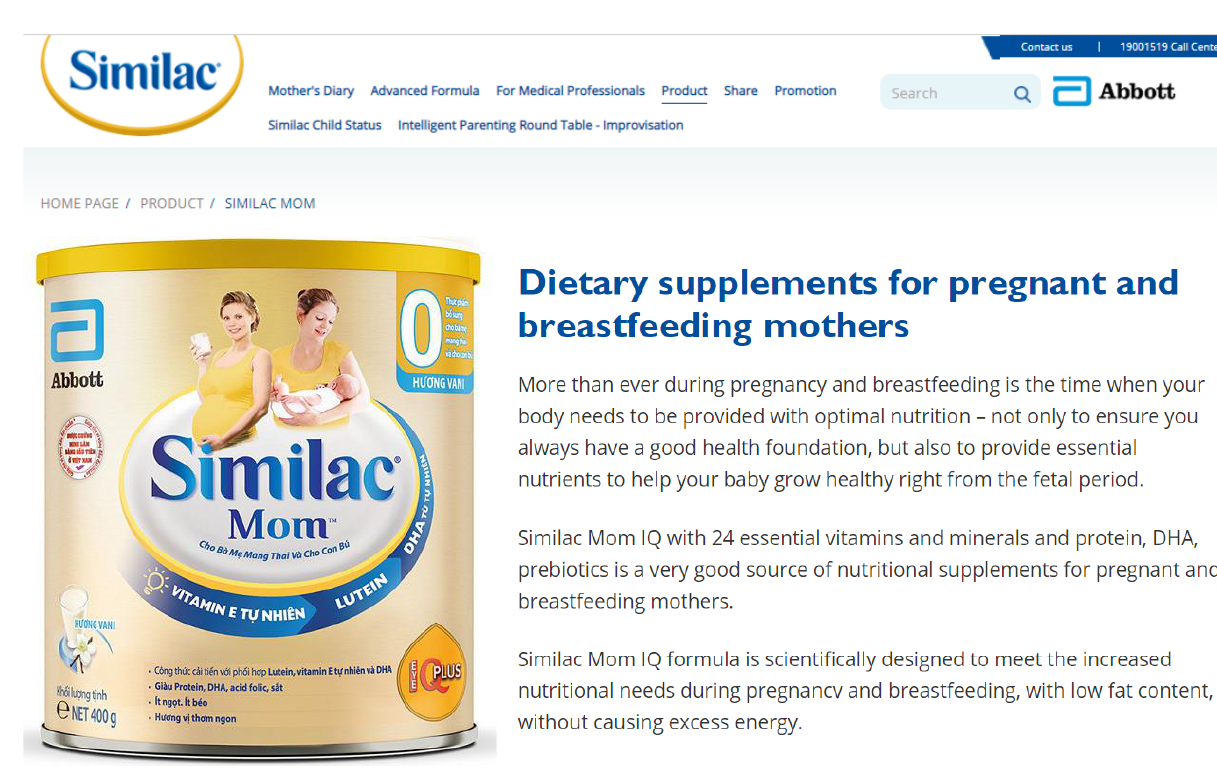
Figure 2. Benefit icons and nutrition and health claims on label of Similac Mom [8]. Picture of baby indirectly confers that these benefits extend to baby too.